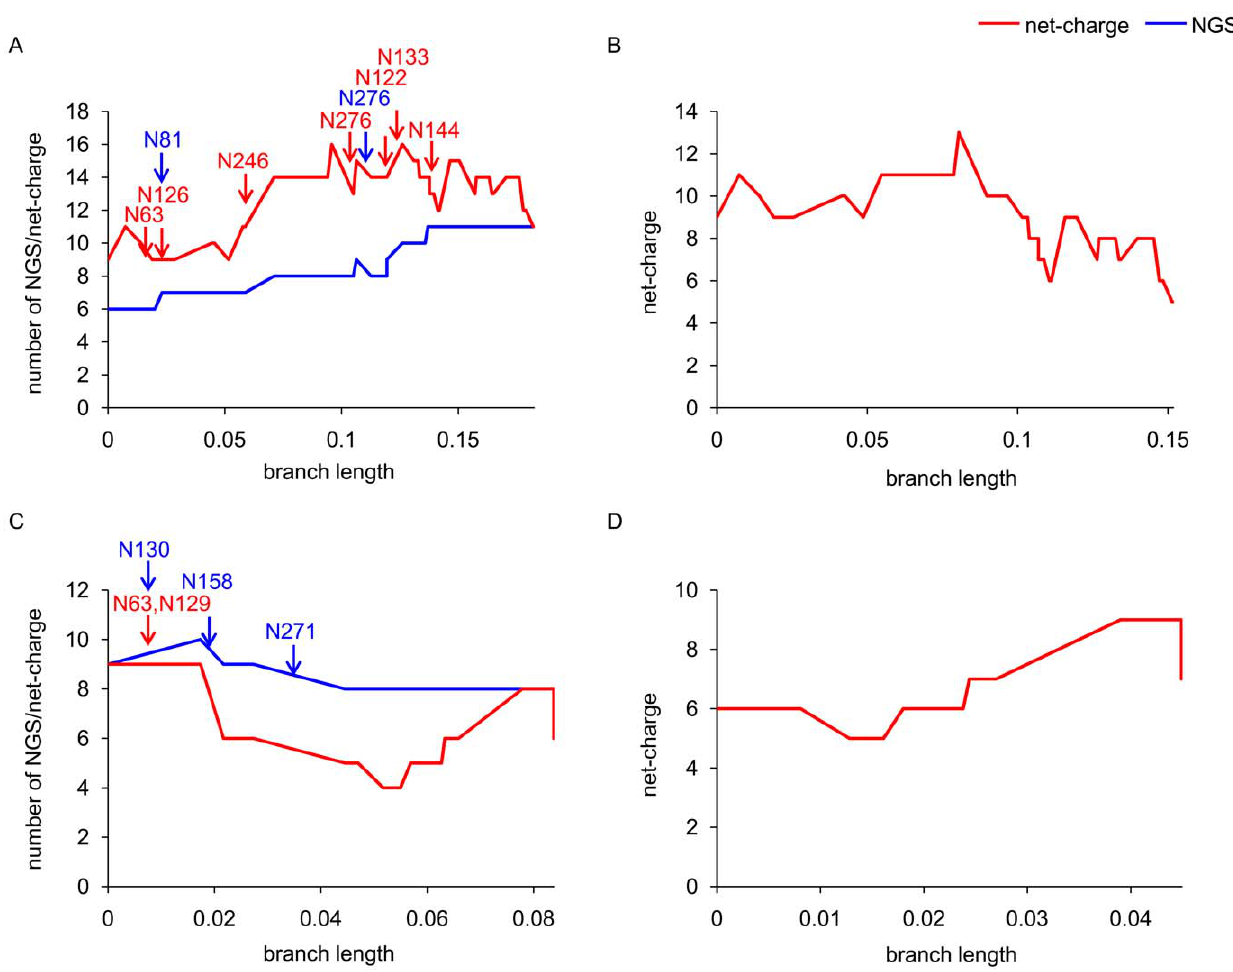
Figure 4. Net-charge and number of NGS in HA1 on the trunk branches. The sums of changes in the net-charge (red line) and the number of NGS (blue line) in HA1 from the root to each node along all trunk branches (A: A/H3N2 virus; C: A/H1N1 virus) and that in the net-charge along NGS 6 trunk branches (B: A/H3N2 virus; D: A/H1N1 virus) were plotted against the total branch length from the root to the node. The red and blue arrows indicate the trunk branches where gains and losses of NGS occurred in HA1, respectively, with the amino acid positions of NGS.